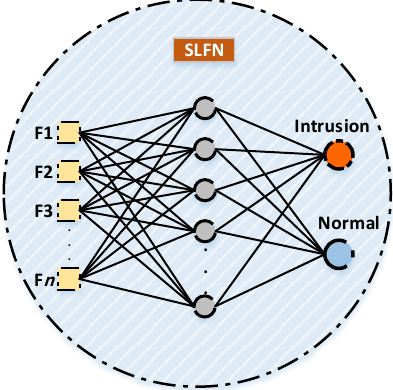
Figure 2. Single Hidden Layer Feed-Forward Neural Network